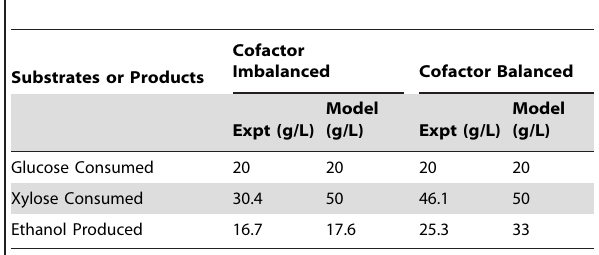
Table 1. Comparison of model prediction with experimentally measured ethanol production and consumed